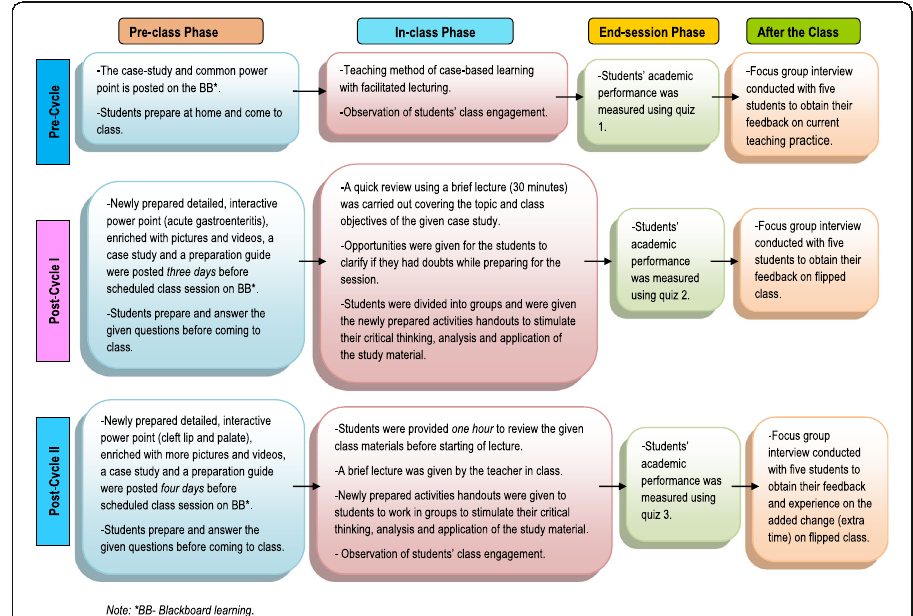
Fig. 1 Action research cycles showing the transition from case-based learning to flipped